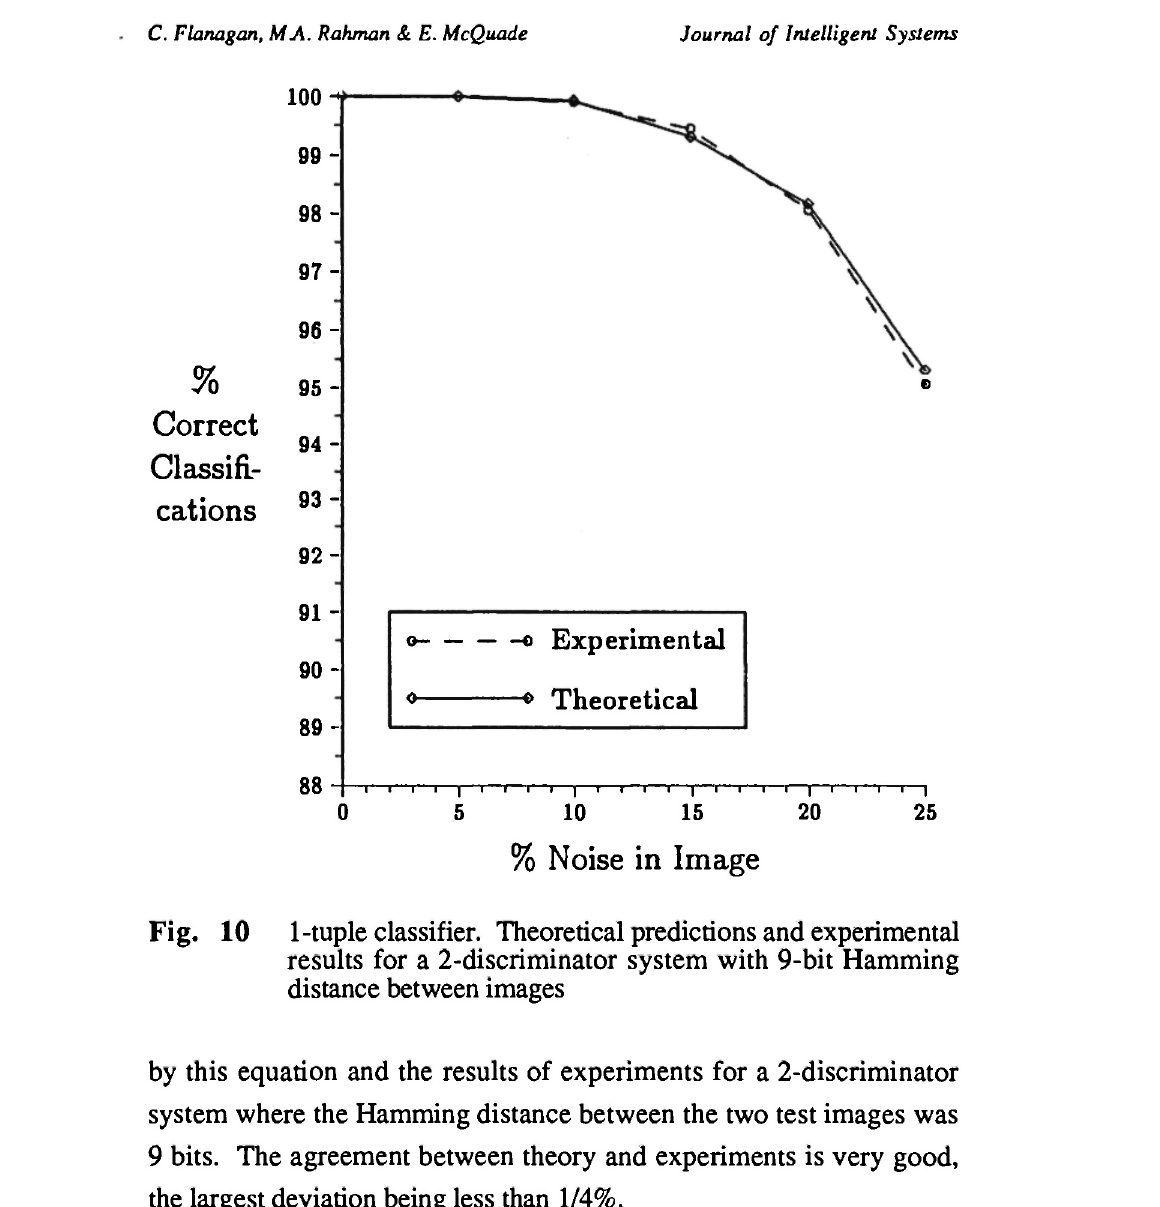
Fig. 10 1-tuple classifier. Theoretical predictions and experimental results for a 2-discriminator system with 9-bit Hamming distance between